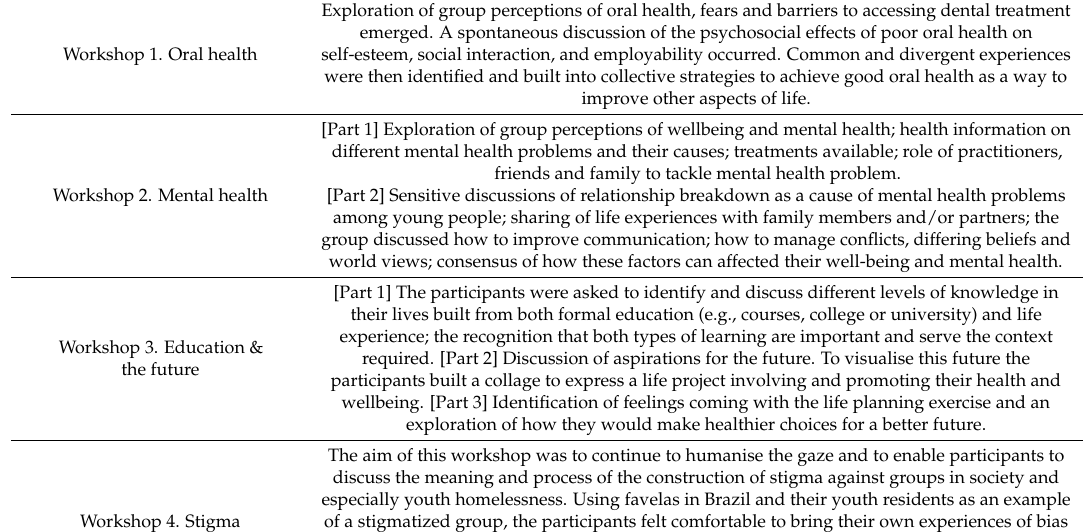
Table 2. Content and implementation of co-designed workshops